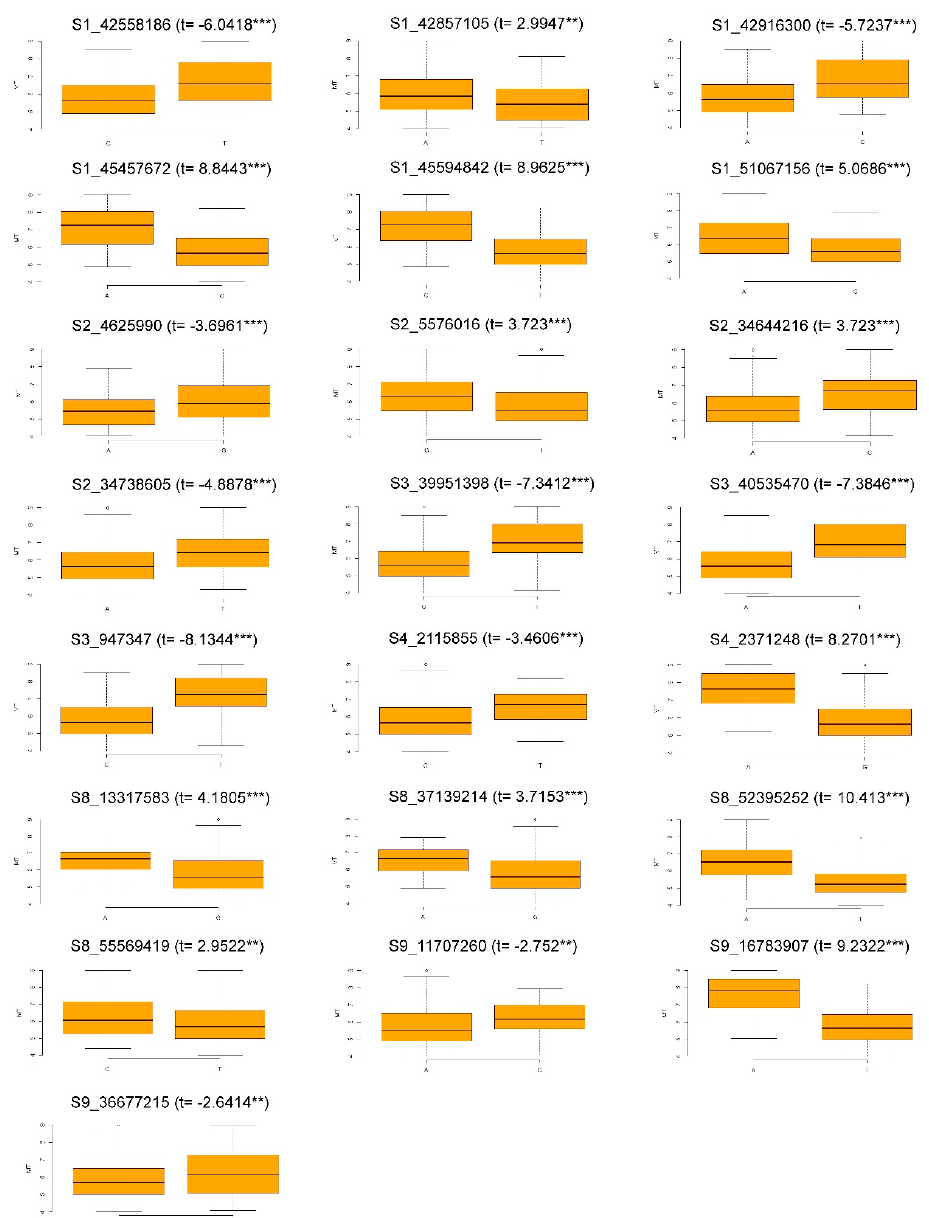
Figure 2. Box plot for the mean WM evaluation plotted according to the haplotype for the 22 SNPs associated with WM response. The X-axis represents the two alleles for each SNP, while the Y-axis corresponds to the phenotype (1 to 9 disease severity scale). T, T-student test value; ** p < 0.01; *** p < 0.001.